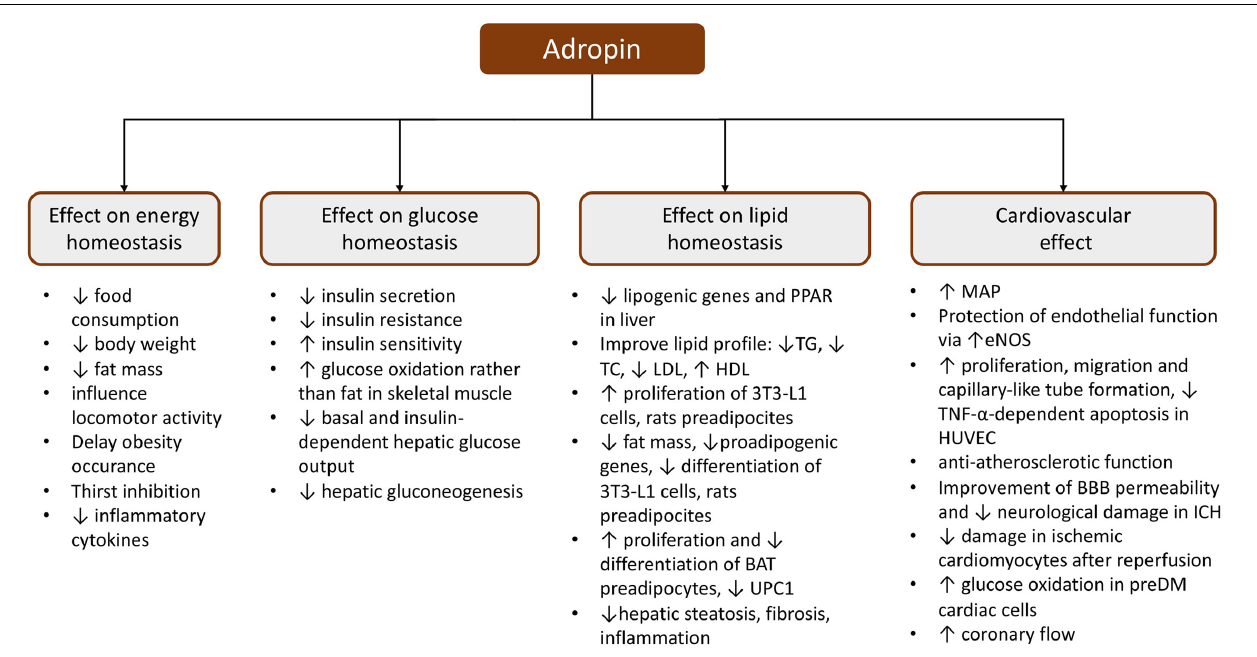
FIGURE 3 | Schematic presentation of the pleiotropic effect of adropin. BAT, brown adipose tissue; BBB, blood–brain barrier; eNOS, endothelial nitric oxide synthase; HDL, high-density lipoprotein; HUVEC, human umbilical vein endothelial cells; ICH, intracerebral hemorrhage; LDL, low-density lipoprotein; MAP, mean arterial pressure; PPAR, peroxisome proliferator-activated receptor; TC, total cholesterol; TG, triglyceride; TNF- α , tumor necrosis factor α ; UPC1, uncoupling protein